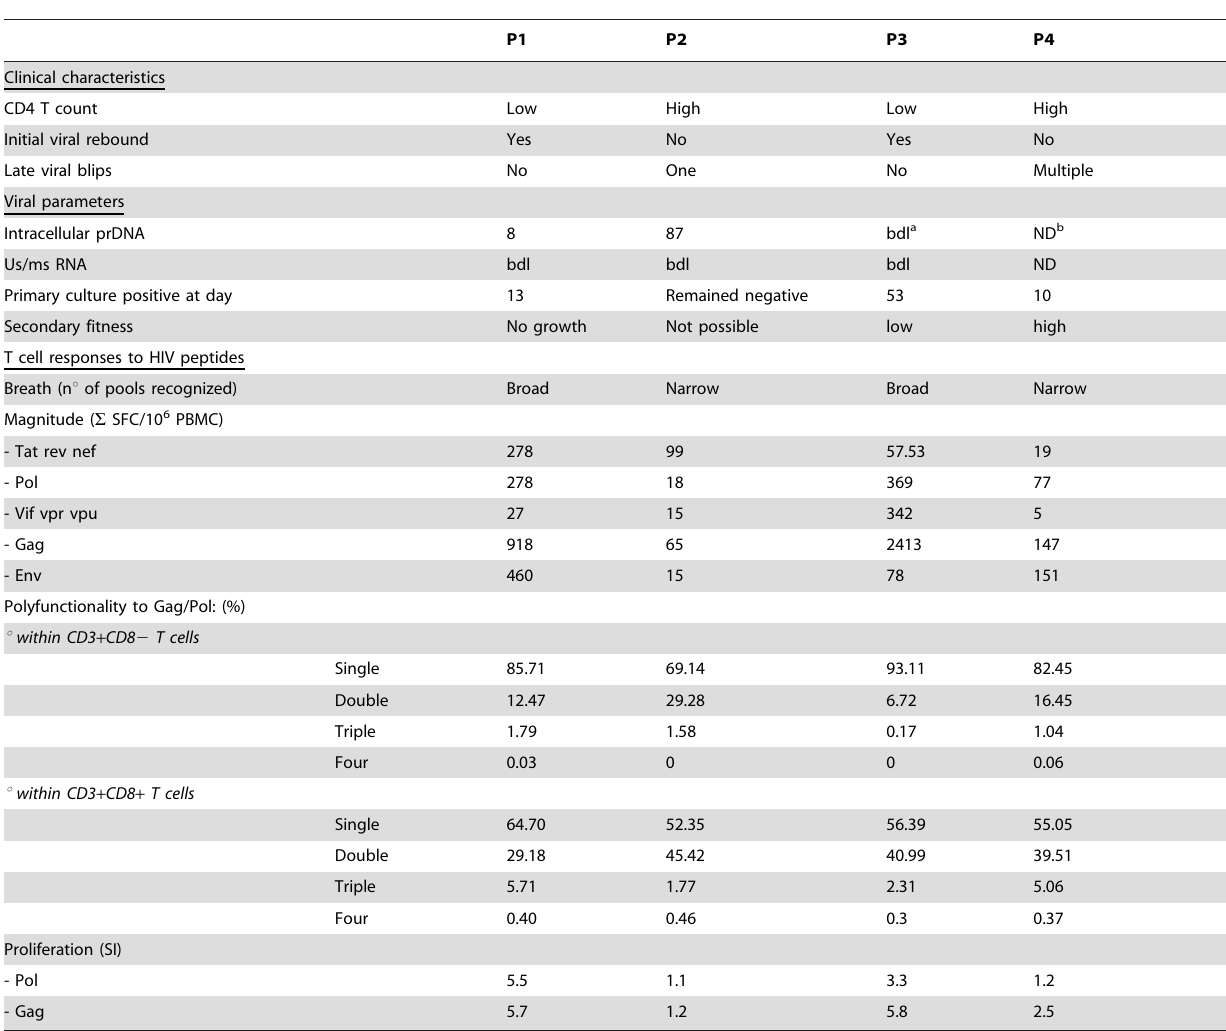
Table 2. Summary of secondary controllers characteristics